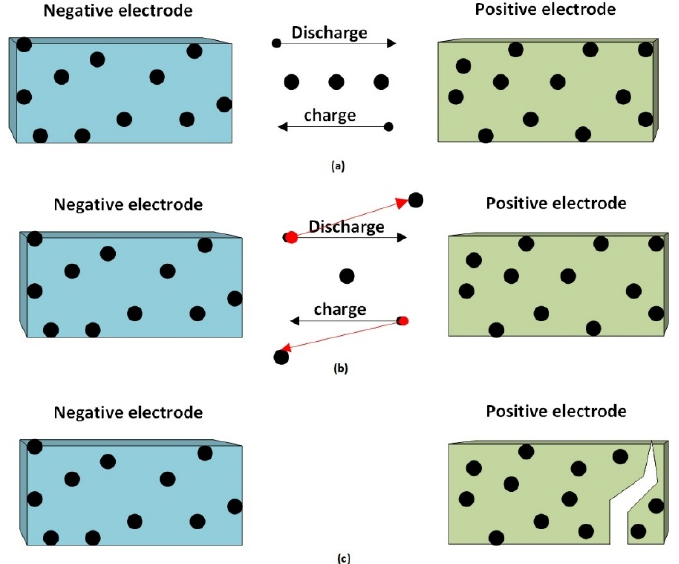
Figure 1. Loss in battery total capacity versus time: ( a ) normal transition of ions between electrodes. ( b ) Effect of side reaction on transition. ( c ) Impact of structural decay on ion loss.